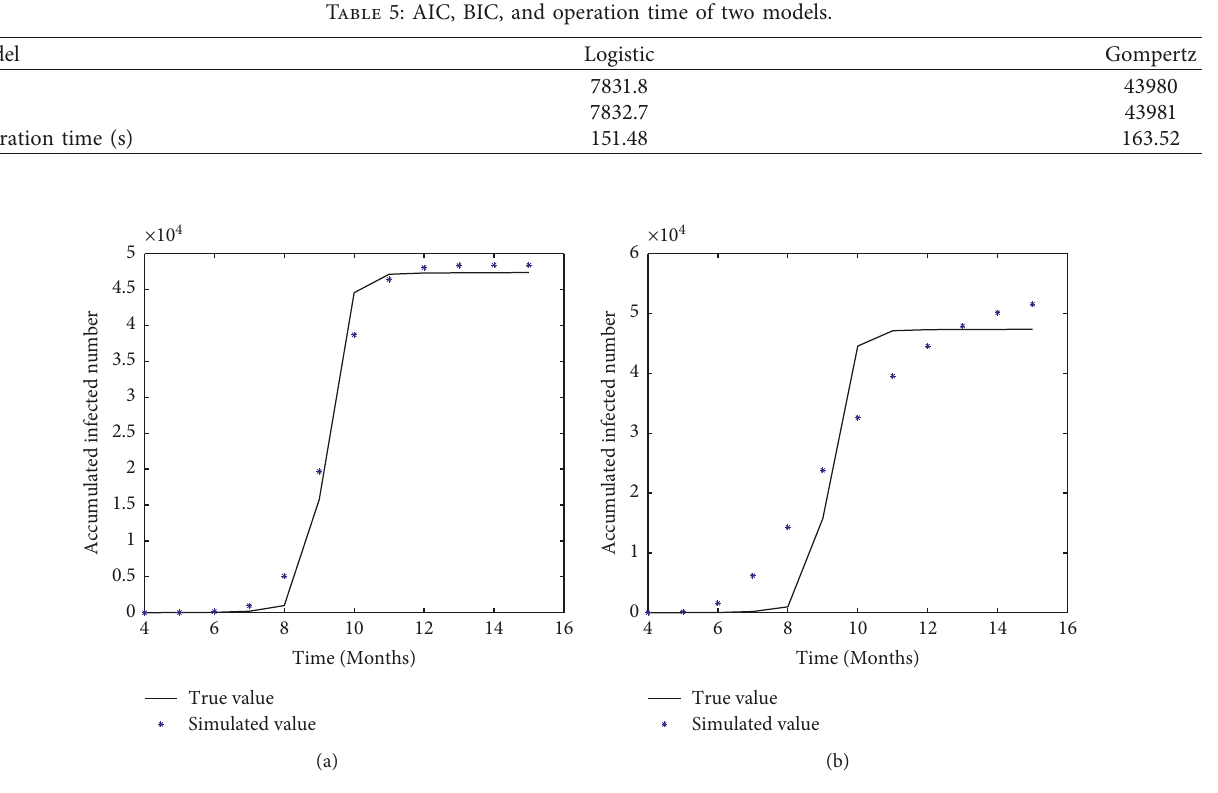
Figure 3: Comparison between the observed data and simulated data of the IABC-SMC algorithm. (a) Logistic model. (b) Gompertz model. � 5 ,a � 0 . 4 , T � 6 , and t � Here, the initial states are n � 6000 ,x 0